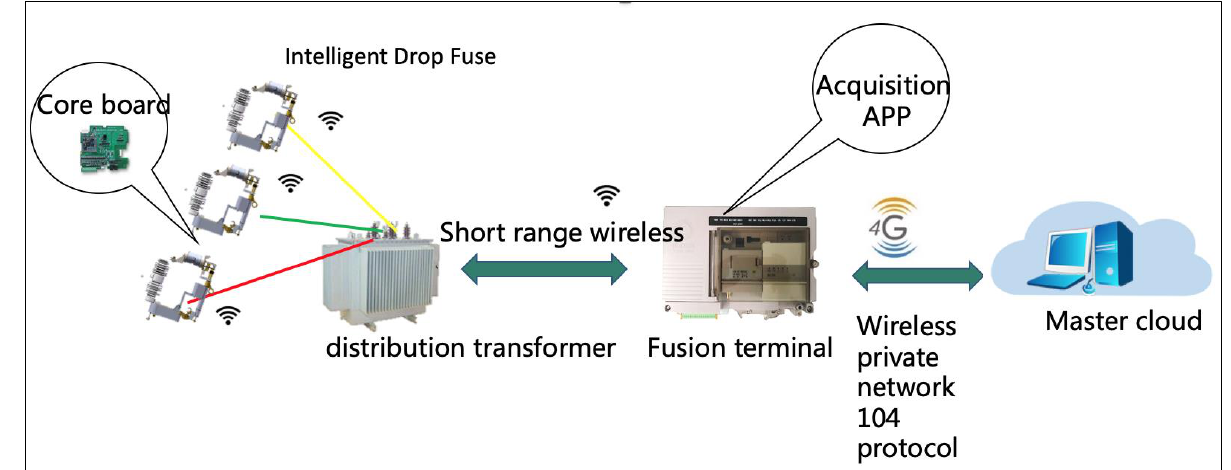
Figure 2. Intelligent fuse service interaction diagram